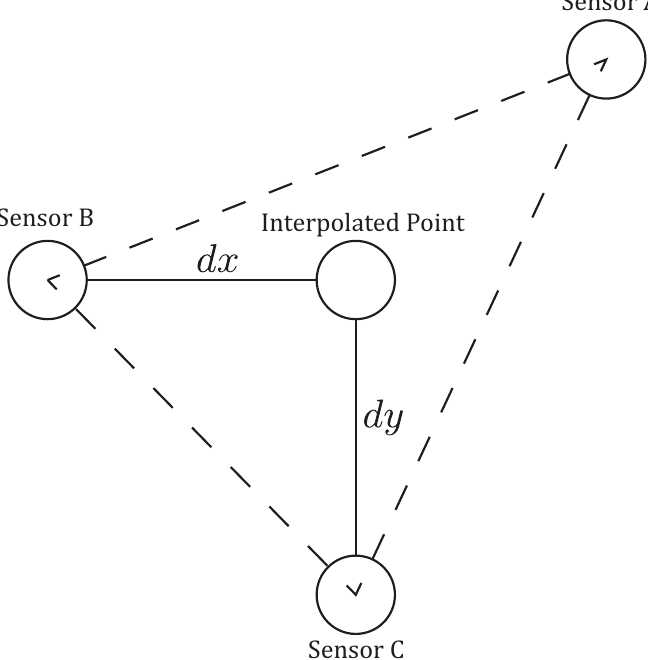
Figure 5. Schematic of how the velocity gradient, ∇ v ( x , t ) , was computed from sensor measurements. Using wind measurements from three independent sensors, a linear function was generated for a triangular element. This function was then used to interpolate the wind to an interpolated point. A finite-difference scheme, Equation (4), was then used to calculate the gradient of the two components, u and v , of the horizontal